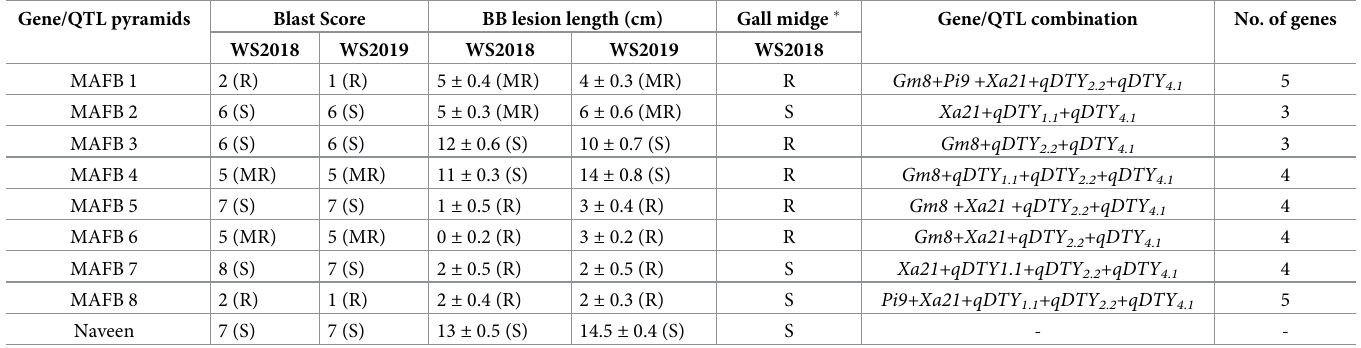
Table 1. Disease reaction (blast, bacterial blight, and gall midge) of pyramided lines with different gene/QTL combinations developed through Marker Assisted Forwarding Breeding (MAFB) approach. Gene/QTL